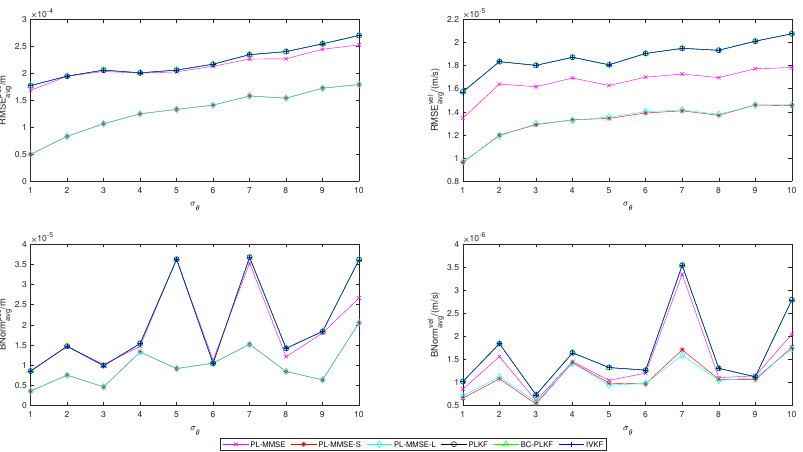
Figure 8. Time-averaged RMSEs, BNorms and bearing noise standard deviation at V = 10 − 4 m/s for the PL-MMSE, PLKF, BC-PLKF and IVKF algorithms, as well as, the PL-MMSE algorithm with nonlinear constraints proposed in the paper.